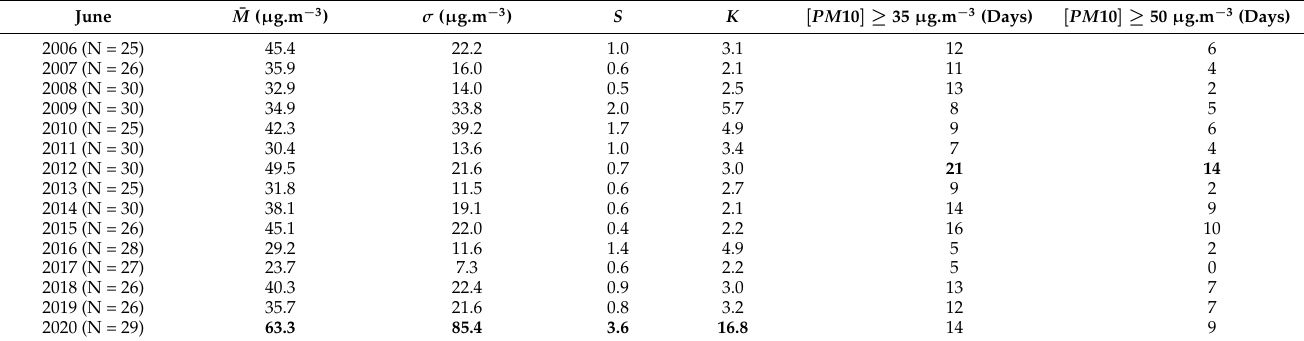
Table 4. Mean ( ¯ M ), standard deviation ( σ ), Skewness ( S ), Kurtosis ( K ), and number of dusty days superior or equal to 35 and 50 µ g.m − 3 for PM 10 daily data in June between 2006 and 2020 at PR. N represents the data point number and the numbers in bold the maximum